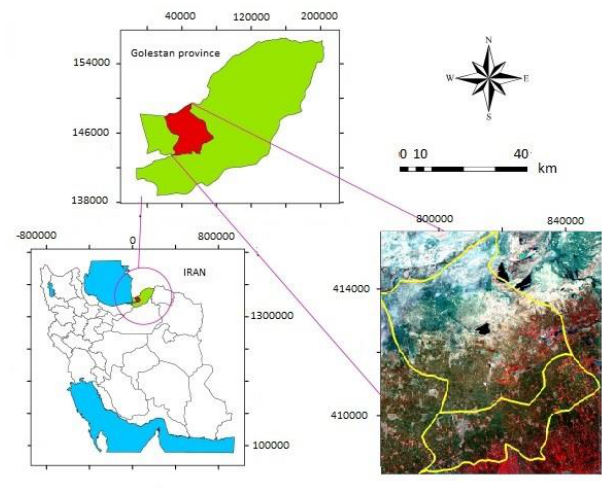
Figure 1. Location of study area